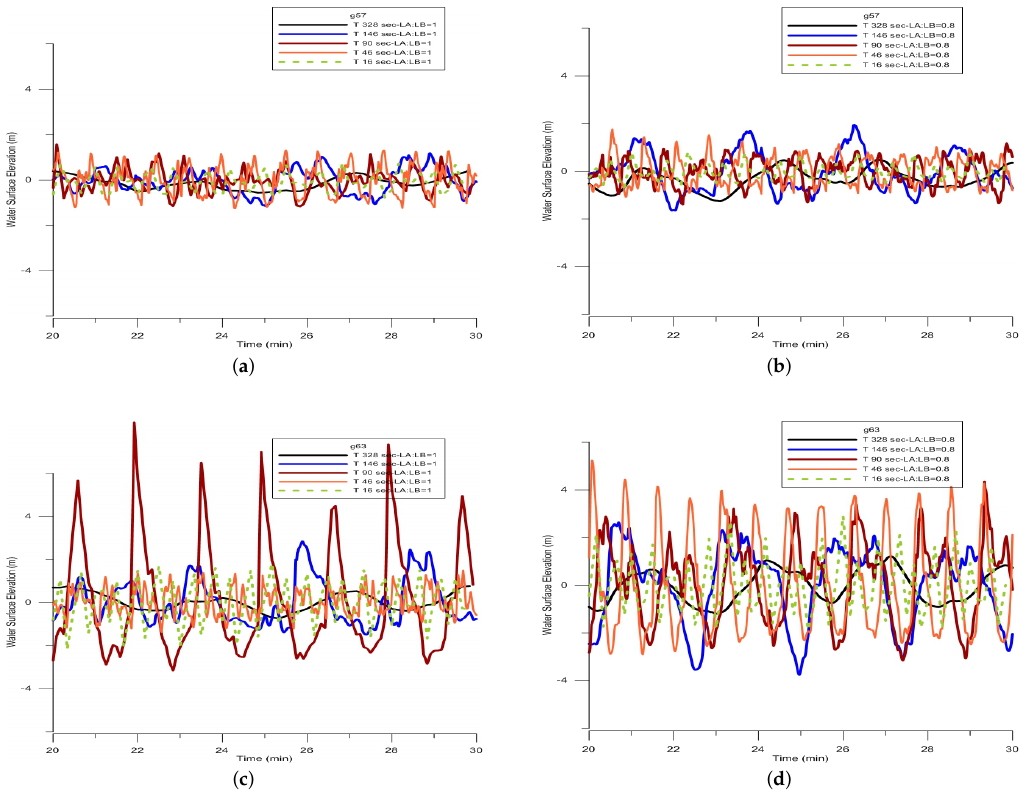
Figure 3. Time history of water surface elevation computed by the simulation of the sinusoidal line crest long wave with a 1-m wave amplitude with T = 16 s, T = 46 s, T = 90 s, T = 146 s, T = 328 s for LA/LB = 1 (left column), for LA/LB = 0.8 (right column) in Gauge 57 ( a , b ) and Gauge 63 ( c , d ).